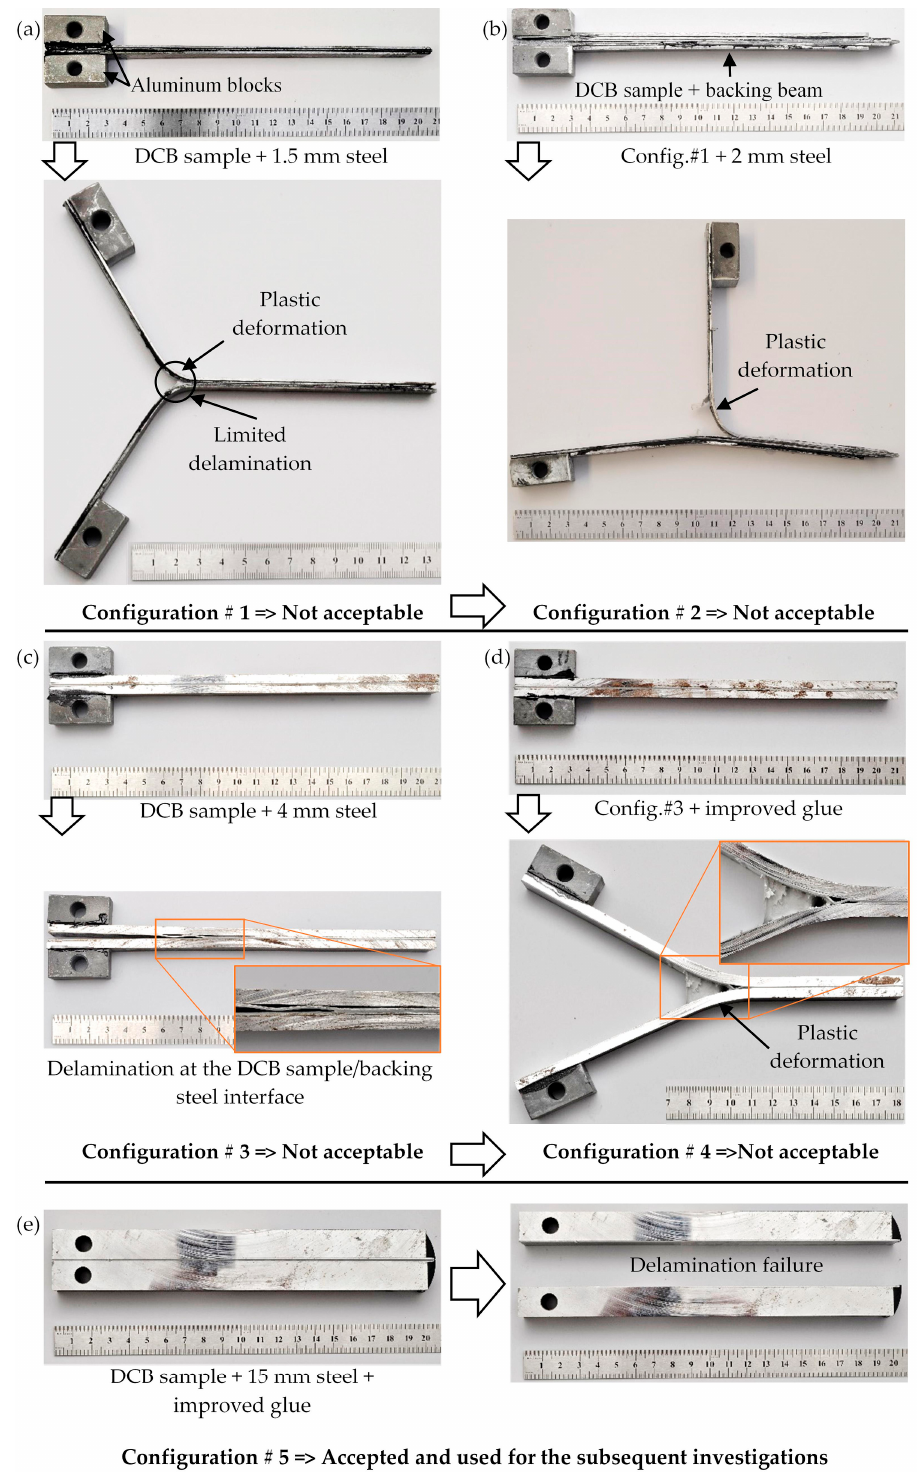
Figure 6. Development approach of the DCB specimen design for MPM sandwich in configurations: ( a ) 1, ( b ) 2, ( c ) 3, ( d ) 4 and ( e ) 5.